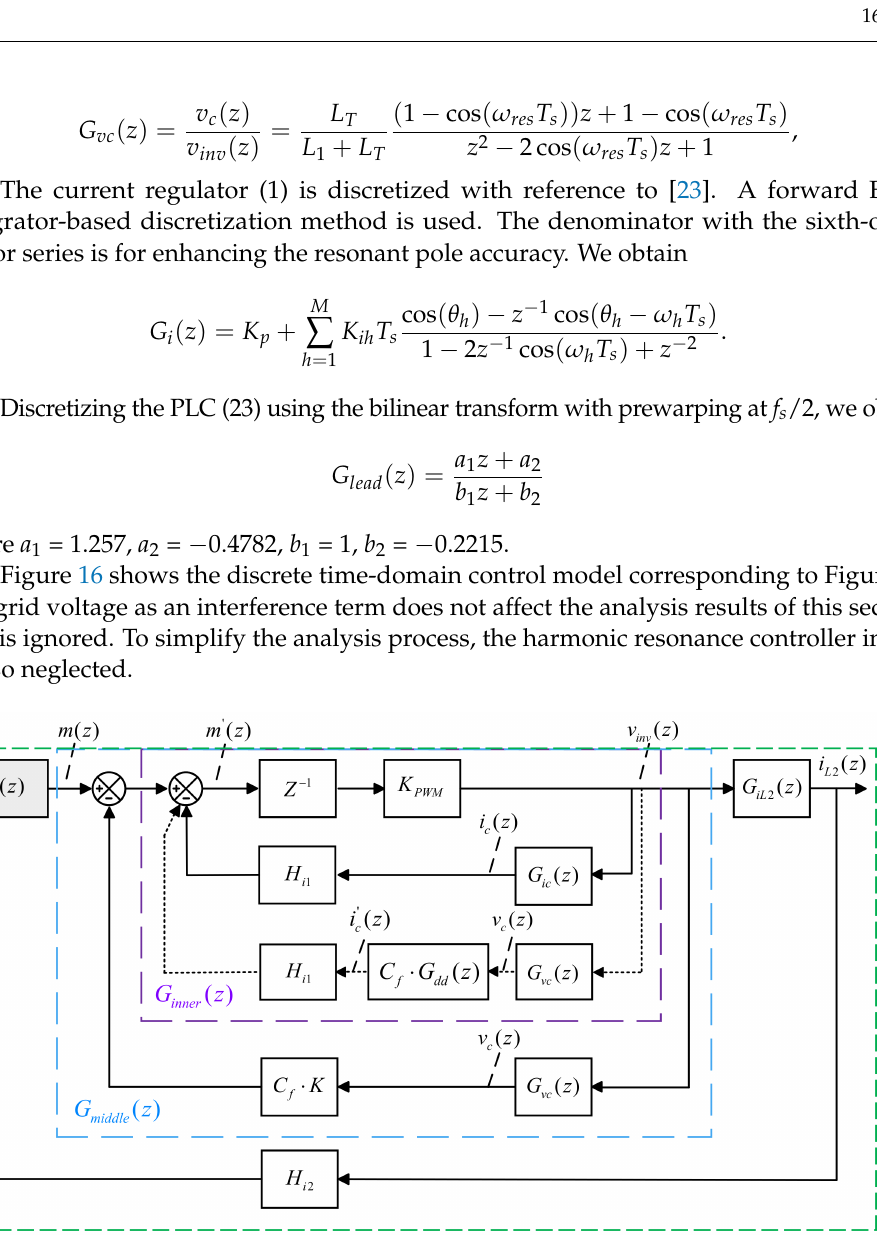
Figure 16. Block diagrams of the proposed control method in discrete-time